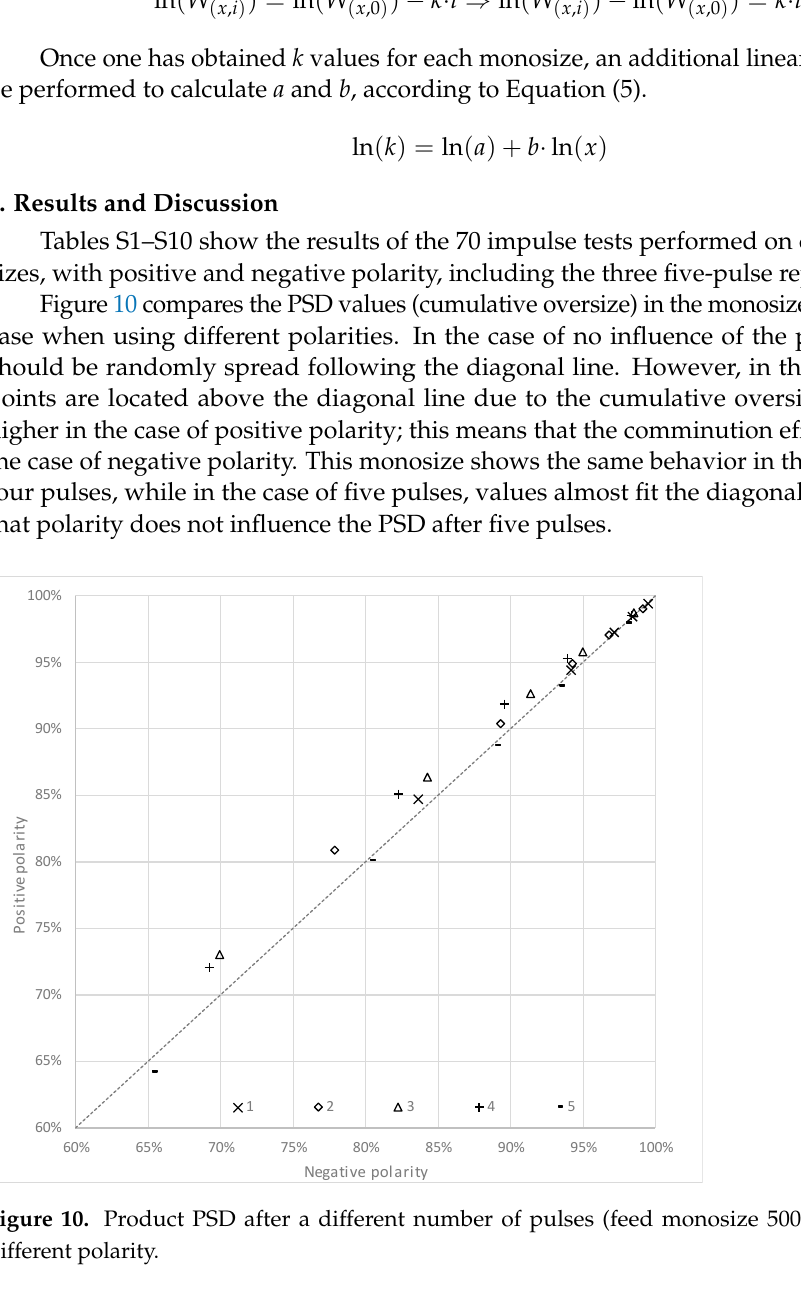
Figure 11. Product PSD after a different number of pulses (feed monosize 3350/2000 µm) and dif- ferent polarity.